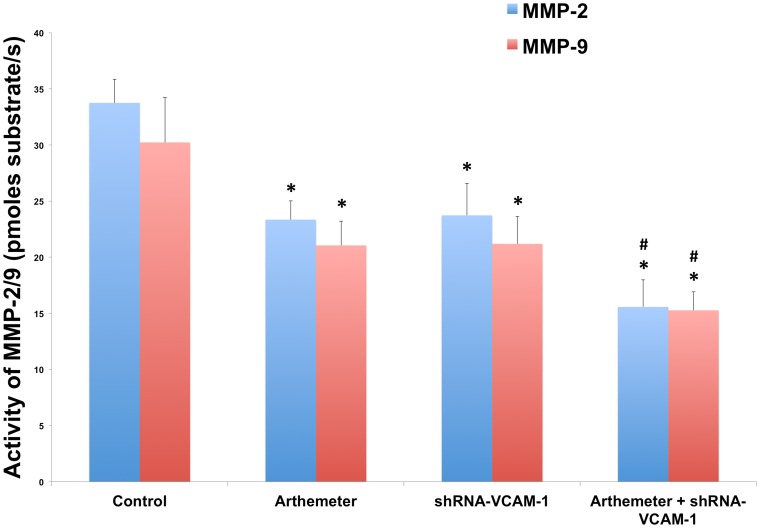
The effects of artemether, shRNA-VCAM-1 and artemether combined with shRNA-VCAM-1 on the enzymatic activity of MMP-2/9.Enzymatic activity of MMP-2/9 under the treatments of artemether (300 µmol/L), shRNA-VCAM-1 and artemether combined with shRNA-VCAM-1 was investigated by fluorescently quenched gelatin assay. The activity of the MMPs was expressed as picomoles substrate/s. The activity of both MMPs was inhibited significantly by artemether and shRNA-VCAM-1 compared with the control group. Artemether+shRNA-VCAM-1 displayed even greater inhibitory effect on enzymatic activity over single artemether or shRNA-VCAM-1 treatments. *P<0.05 (compared with control group); #
P<0.05 (compared with artemether or shRNA-VCAM-1 group). n = 4.